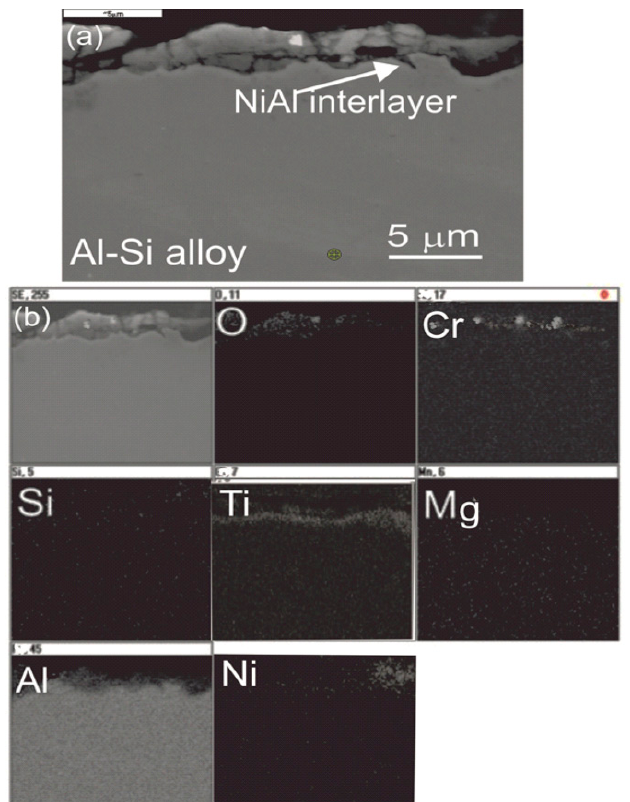
Figure 14. ( a ) SEM micrograph of the cross-section of the Al 2 O 3 -15 wt.% TiO 2 /NiAl/Al-Si coating system after the erosion test, and ( b ) map of distribution of concentrations of O, Cr, Si, Ti, Mg, Al, and Ni taken from the region of the interface.